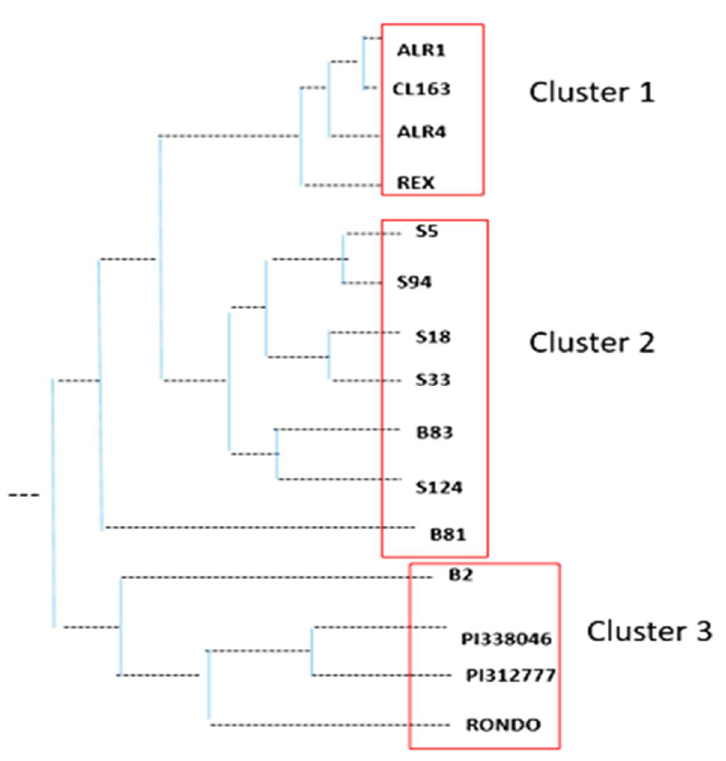
Figure 4. Dendrogram exhibiting genetic relationship among the accessions in terms of allelopathic potential. Accessions within same cluster (red box) are genetically similar as compared to the accessions in different clusters as indicated by Nei’s genetic distance.